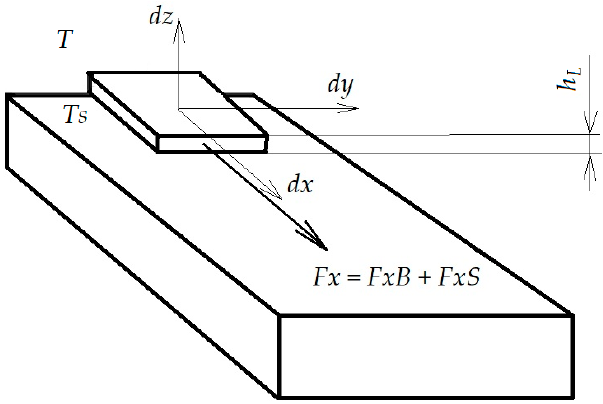
Figure 1. Model of applying polymer on the fabric surface.